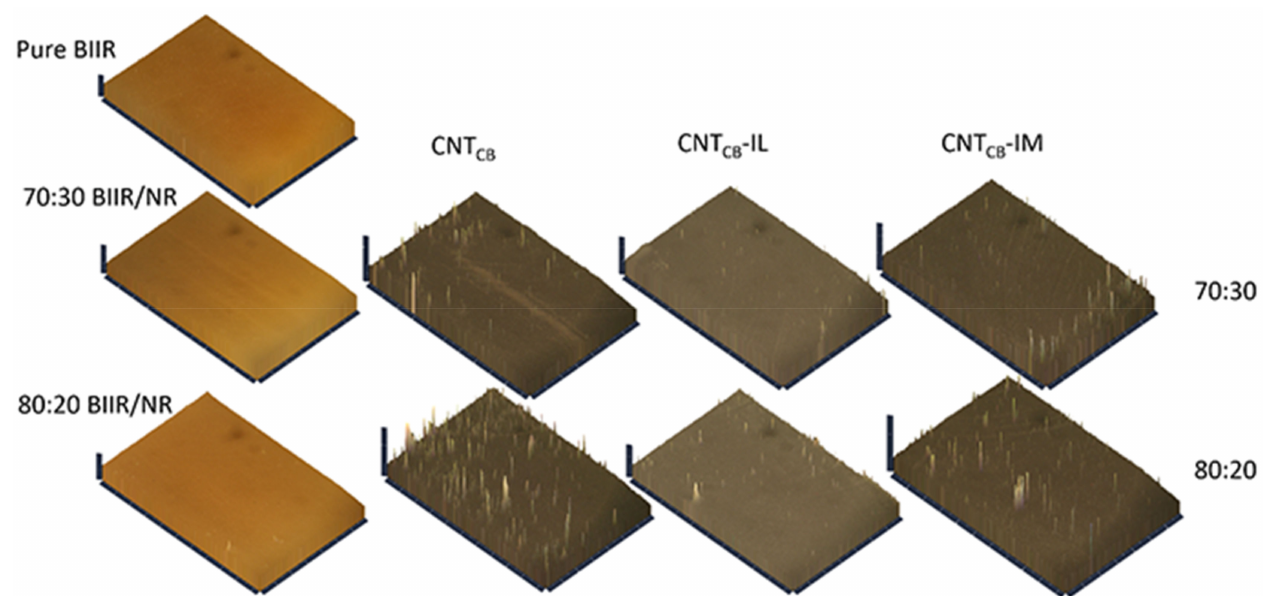
Figure 7. Morphologies of pure rubbers and their composites with and without IL and IM modifiers, BIIR:NR ratios of 70:30 and 80:20 before healing propagation.